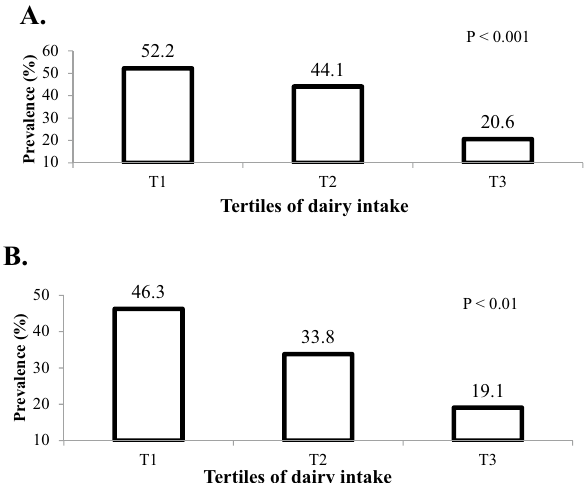
Figure 1. Prevalence of MUO based on IDF ( A ) and IDF/HOMA-IR definition ( B ) in energy-adjusted tertiles of dairy intake.